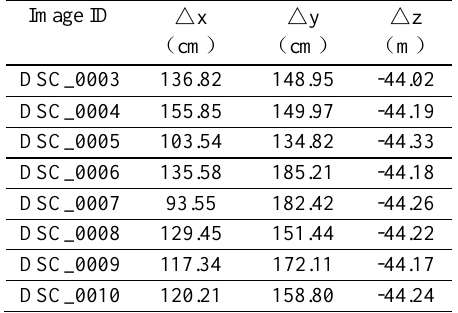
Table1. Deviation between pre and post differential POS data The shaded-releif method of terrain make the terrain contrast characteristic of light and shade distribution through photometric approximate continuous changing hue from simulation of the solar light generated on the ground radiation brightness, and using gray tone or color tone. That makes the